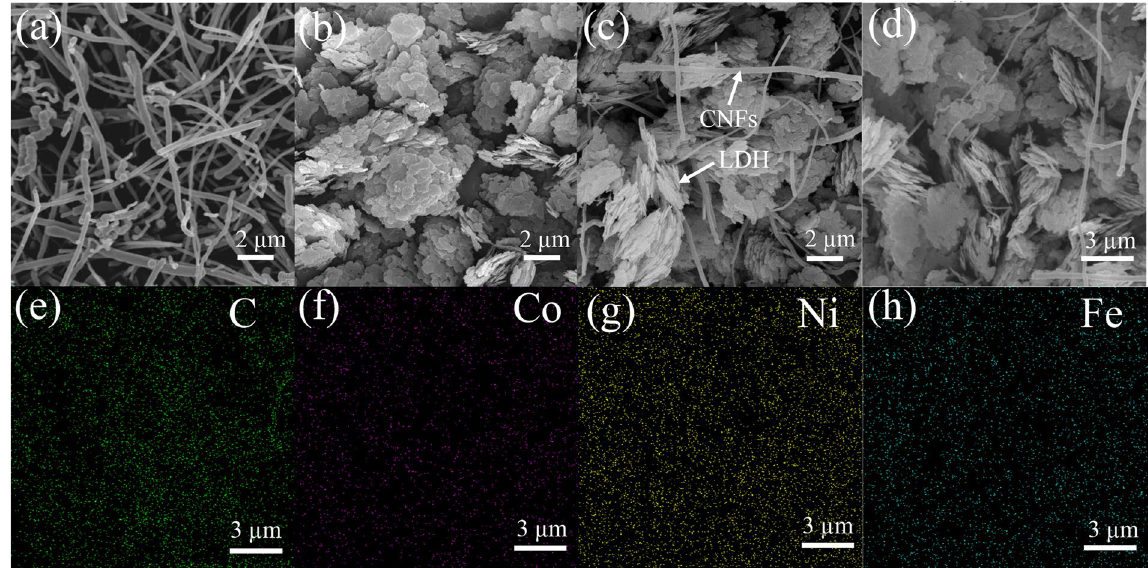
Figure 2. ( a ) SEM image of original CNFs; ( b ) SEM image of the CoNiFe-LDH; ( c ) SEM image of the CoNiFe- LDH/CNFs-0.5 composite; ( d – h ) SEM image and the corresponding elemental distribution maps of C, Co, Ni and Fe the CoNiFe-LDH/CNFs-0.5